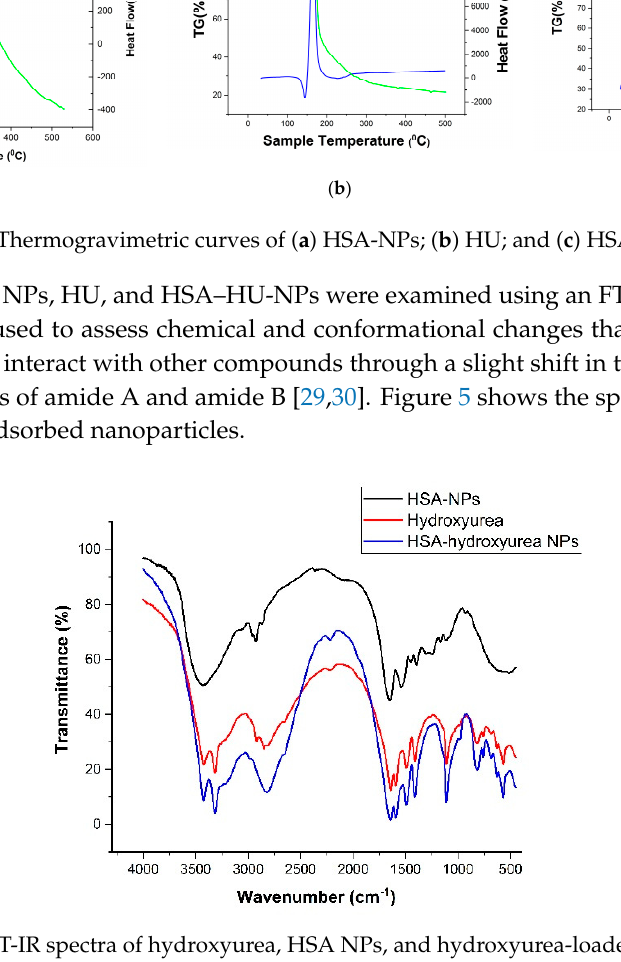
Figure 5. FT-IR spectra of hydroxyurea, HSA NPs, and hydroxyurea-loaded HSA NPs.